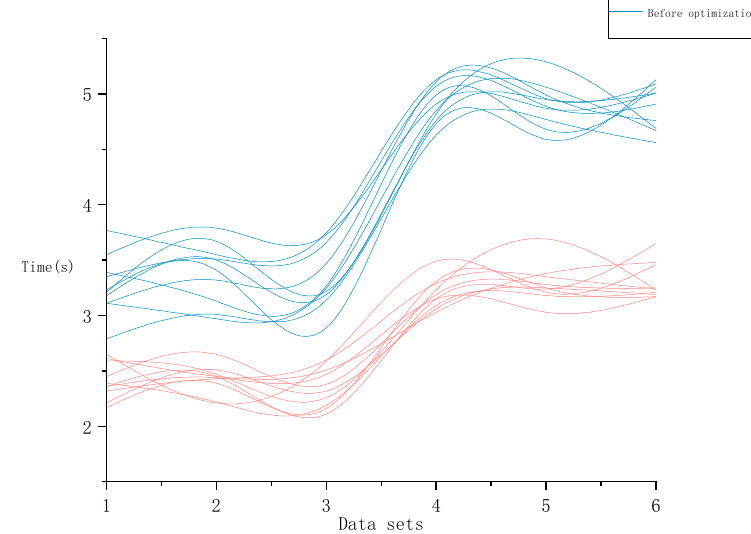
Figure 20. Smoothed response time curves for each dataset.